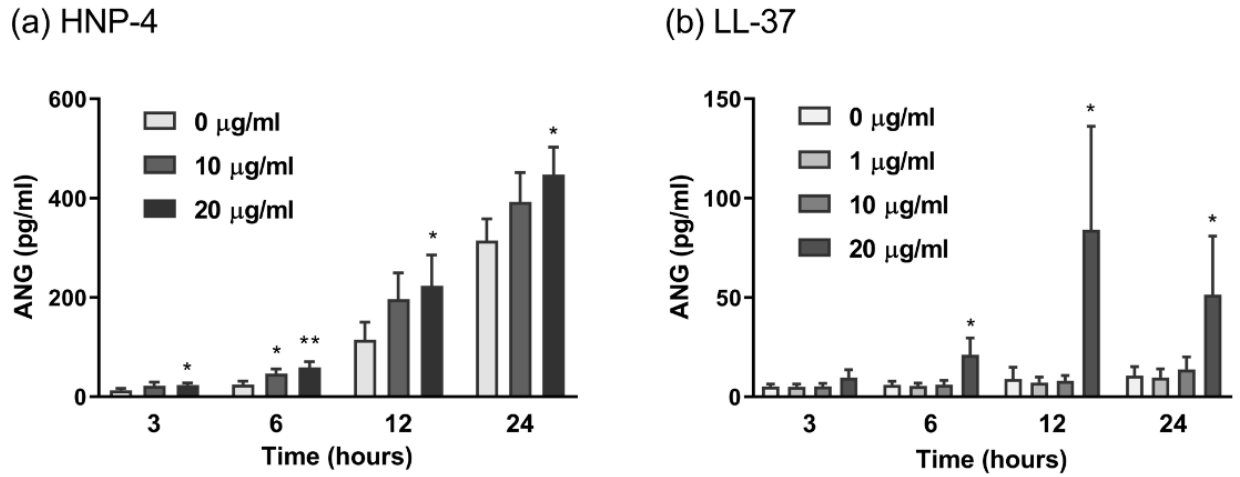
Figure 2. The production of ANG is promoted by HNP-4 and LL-37. Normal human dermal fibroblasts were cultured with 10–20 µ g/mL HNP-4 ( a ) or 1–20 µ g/mL LL-37 ( b ) for 3–24 h. The concentration of ANG in the culture supernatant was determined by ELISA. The data represent the means ± SDs of 3–4 separate experiments. * p < 0.05 and ** p < 0.01 compared with the vehicle at each time point by one-way ANOVA with Tukey’s multiple comparisons